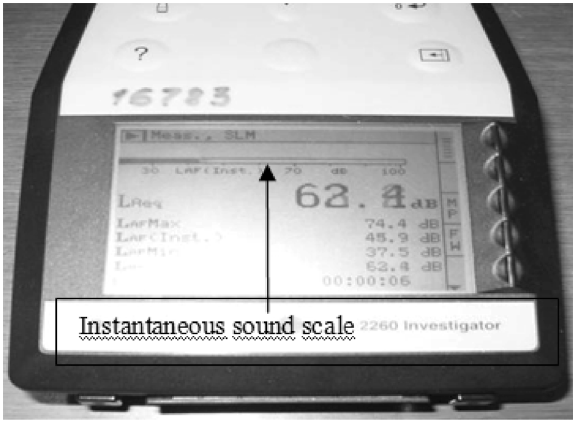
Fig. 3. Instantaneous sound scale of the sound level